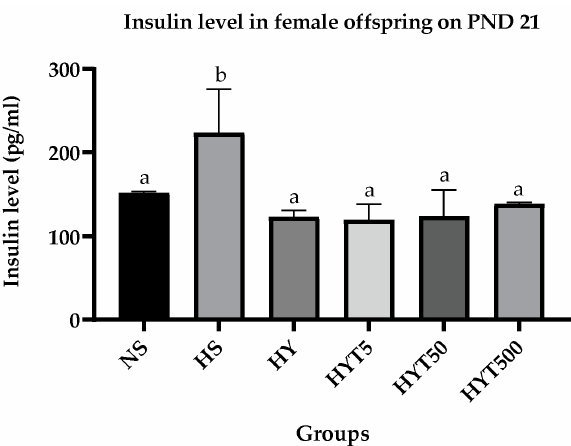
Figure 7. Plasma insulin level of female offspring on PND 21. NS: normal chow and saline; HS: